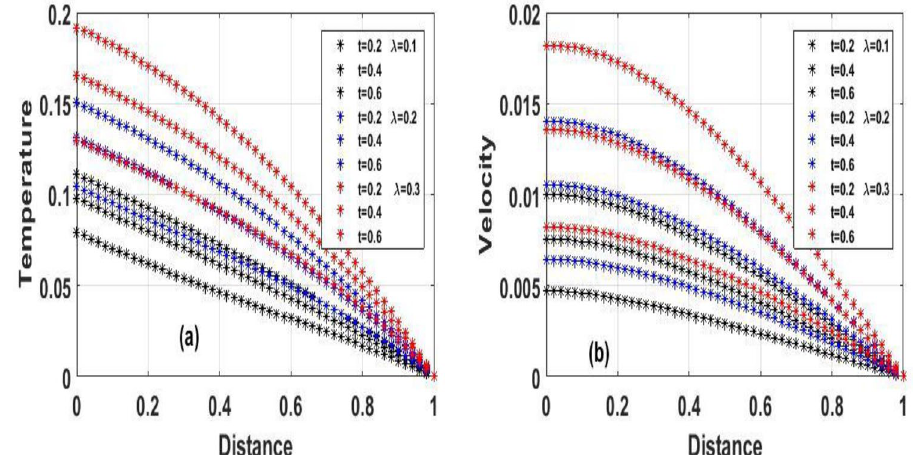
Figure 7. The effect of variation of (cid:31) for Temperature and velocity unsteady state.